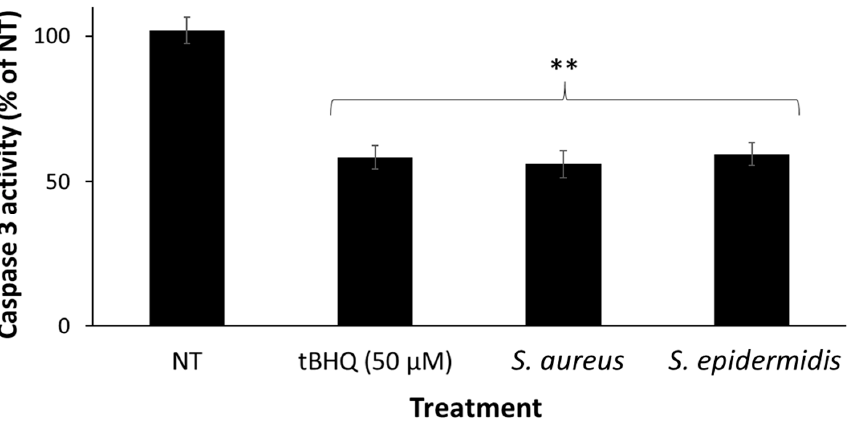
Figure 3. Caspase 3 activity in ex vivo human skin following 24 h of infection with S. aureus and S. epidermidis , and the consequent irradiation with an apoptosis-inducing UVB source at 300 mJ/cm 2 . Both bacteria caused a significant reduction in the caspase 3 protein activity in the skin. Tert - Butylhydroquinone (tBHQ) served as a positive control. The results were normalized to the non- treated control and presented as a percentage of NT. ** p < 0.01, treated sample vs. NT.